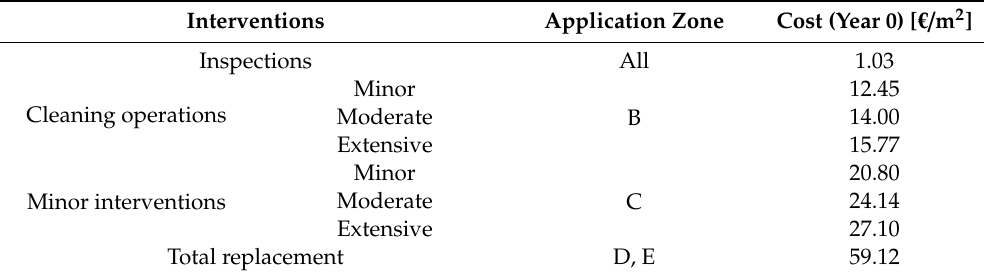
Table 5. Unit costs of the